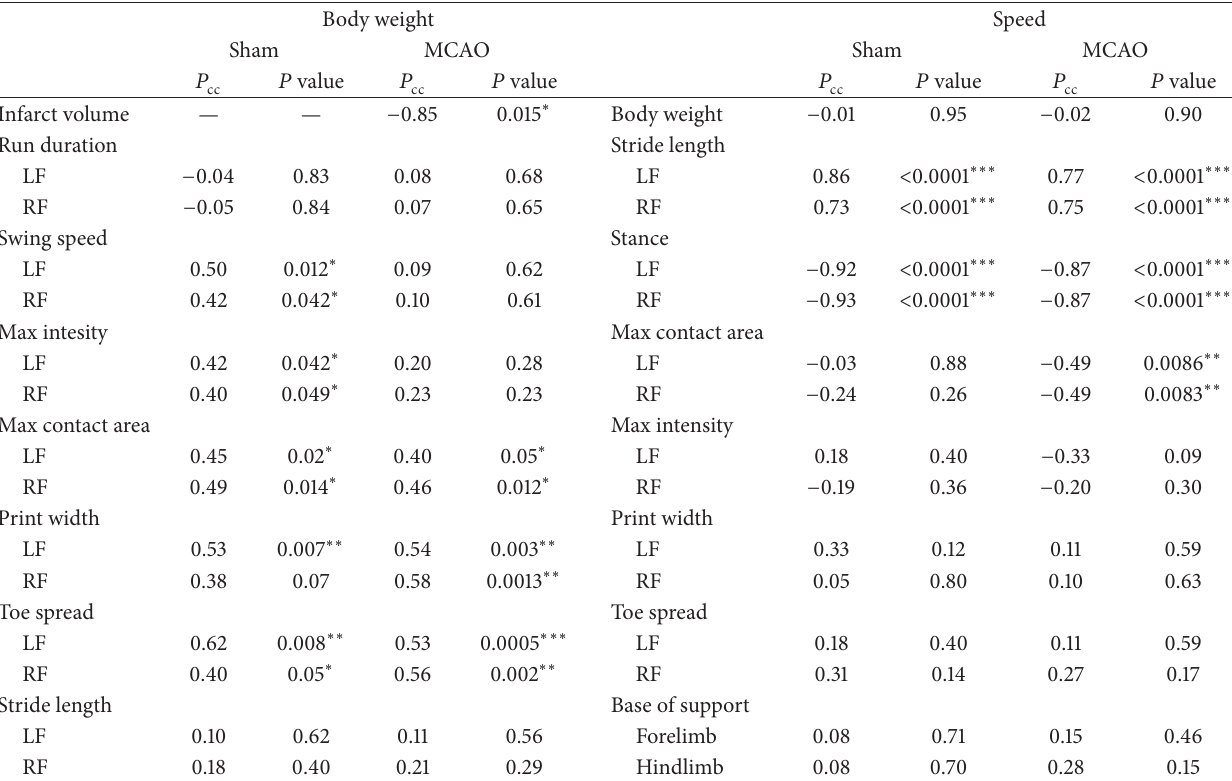
Table 2: Relationships between body weight and speed with gait